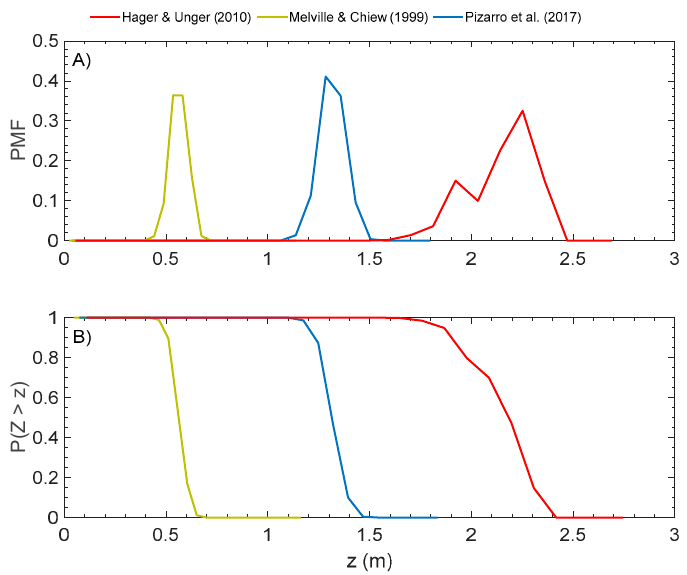
Figure 8. PMF ( a ) and empirical exceedance probability ( b ) of z for k = 2, T = 100 years, and PTP = 0.5. Scour models benchmarking in terms of probabilities.